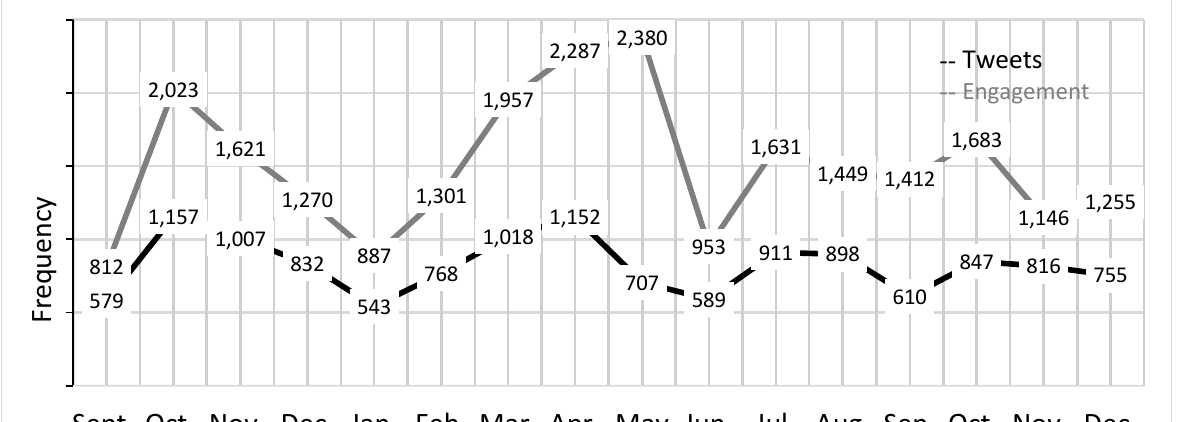
Frequency and Engagement with Gene Editing in Agriculture Tweets